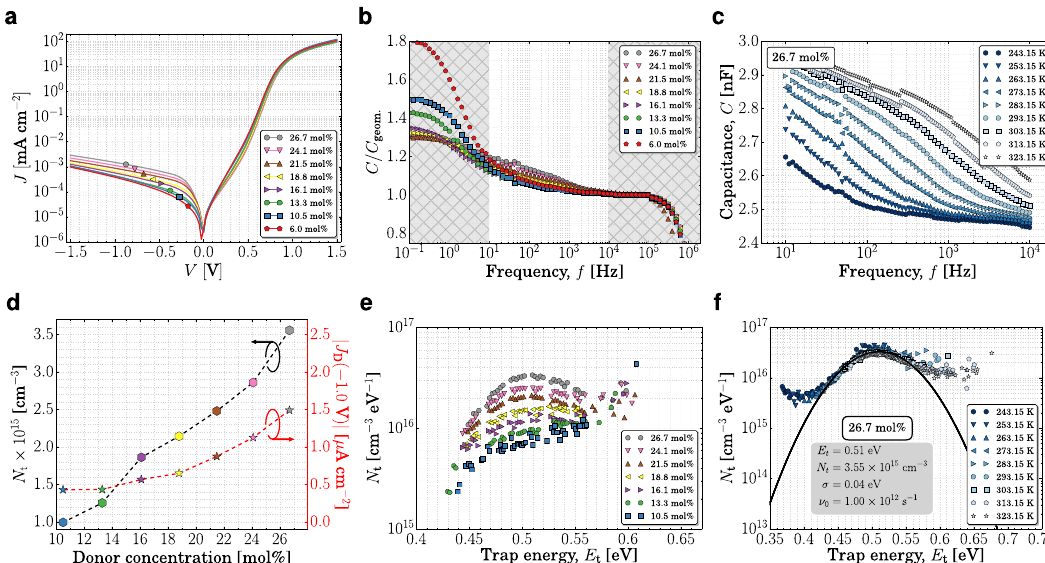
Fig. 3 Increasing the trap density in TPDP:C 60 devices. a Dark JV curves, b normalized capacitance, and e N t at 293.15 K of TPDP:C 60 blends with different D – A mixing ratios. Due to the small capacitive contribution of the traps at very low concentrations, the method fails in reconstructing the trap density of states. Therefore, the results of the 6.0 mol% device are not shown. c Capacitance and f N t for 26.7 mol% at different temperatures reconstructed as proposed previously 44 . d Trap density (left black y -axis) and | J D ( − 1.0 V | (right red y -axis) versus donor concentration. Trap energies represents the energy difference from C 60 LUMO (LUMO C60 - E t ) 62 . The hatched areas in ( b ) show the frequency ranges excluded from the trap analyses as discussed in the text. C geom. refers here to the capacitance at 100 kHz, where the geometric capacitance